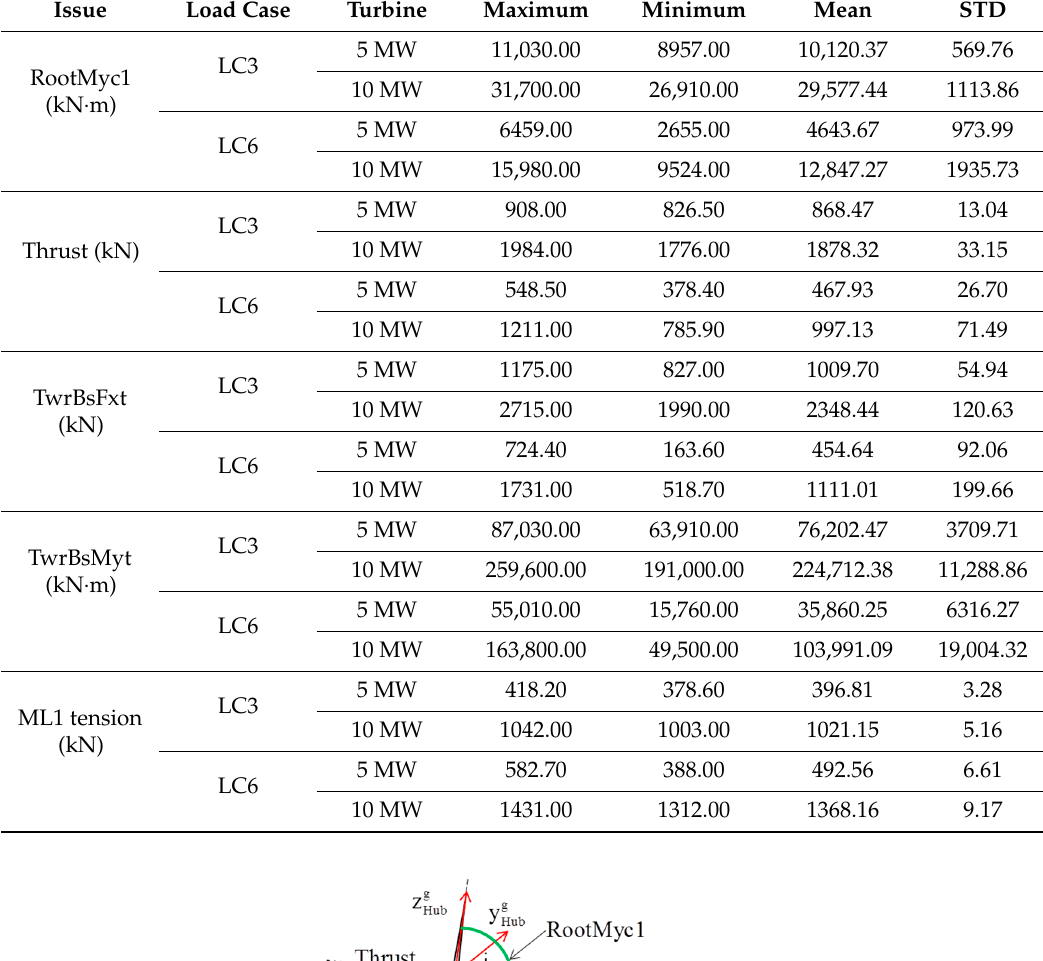
Table 10. Statistics of structural loads of the 5 and 10 MW FOWT.